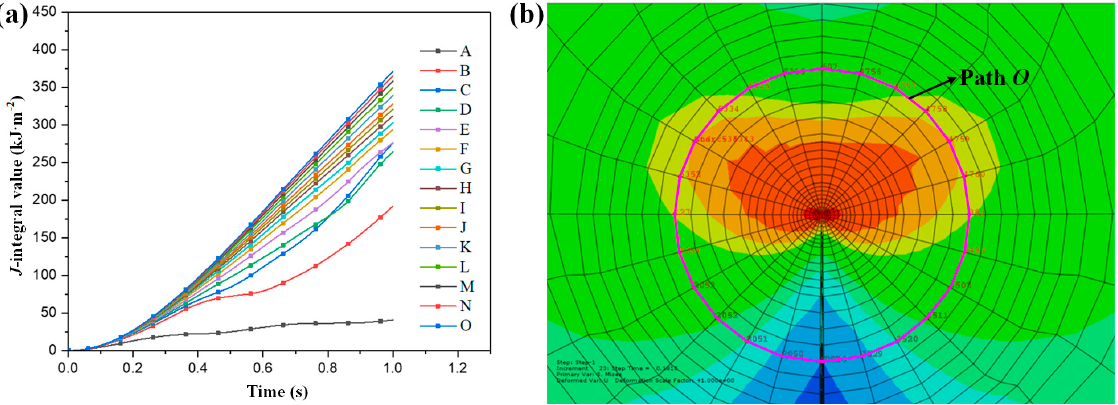
Figure 10. J -integral value of the specimens SENB20 without side grooves: ( a ) J -integral value of Figure 10. J-integral value of the specimens SENB20 without side grooves: ( a ) J-integral value of fifteen integration paths; ( b ) integration path O . fifteen integration paths; ( b ) integration path O